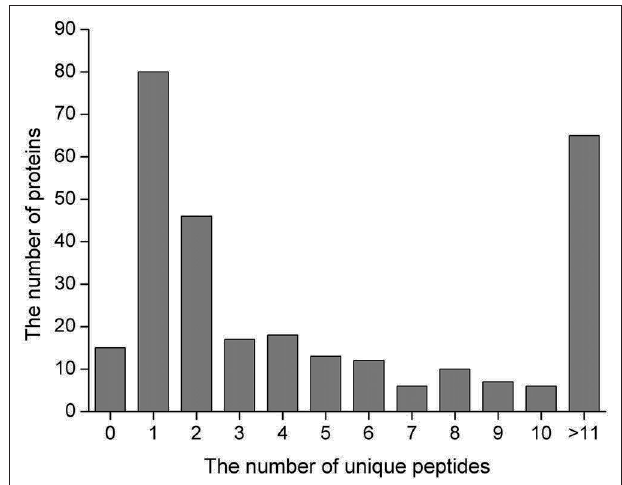
FIGURE 1 | Unique peptides for the identified